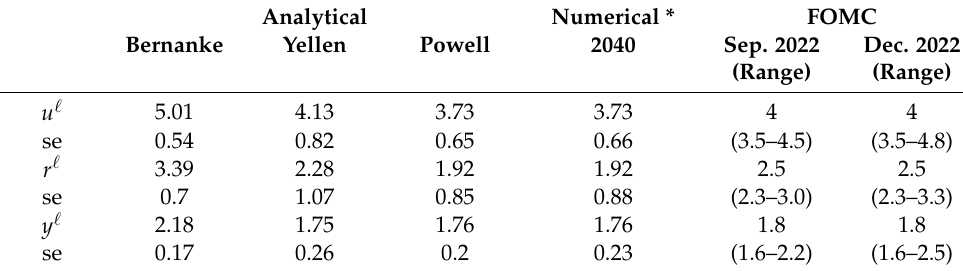
Table 2. Estimates of Longer-run Forecasts: Alternative Methods.